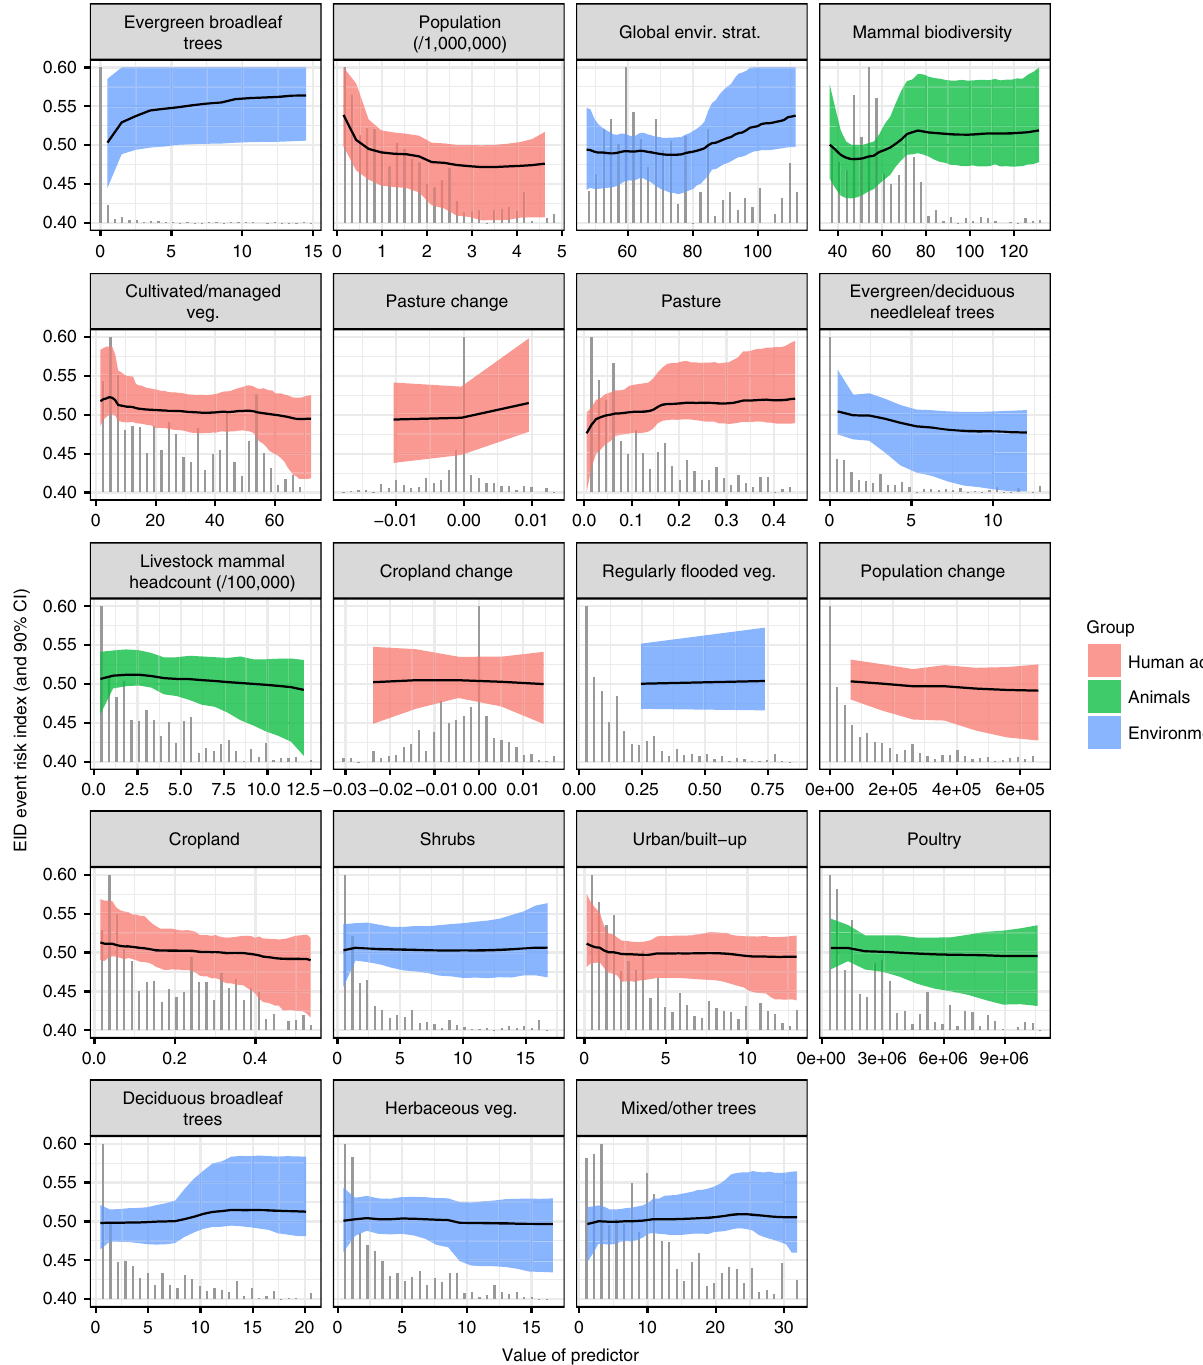
Fig. 2 Partial dependence plots showing the in fl uence on zoonotic EID events for all predictors in the weighted boosted regression tree model, ordered by relative in fl uence. X axes show the range from the 10th to 90th percentiles of sampled values of predictors (e.g., number of mammal species per grid square formammalian richness, or proportion of grid cell for a land cover type). Gray bars show histograms of predictor distribution along X axes. Y axes show the effect on the EID event risk index from that variable. Black lines show the median and colored areas show the 90% con fi dence intervals, computed using a bootstrap resampling regime incorporating uncertainty in EID event locations. The overall prevalence of our outcome, which indexes EID event risk, is fi xed by the resampling regime between 0 and 1, with a mean at 0.5. Y axes are centered around the mean and scaled to 0.1 above and below. Partial dependence plots display the response for an individual variable in the model while holding all other variables constant 26, 61 . They allow a visualization of what are mostly non-linear relationships between drivers and the EID event risk index (in this case, after reporting effort is factored out.). See Supplementary Note 3 for results of the model unweighted by reporting